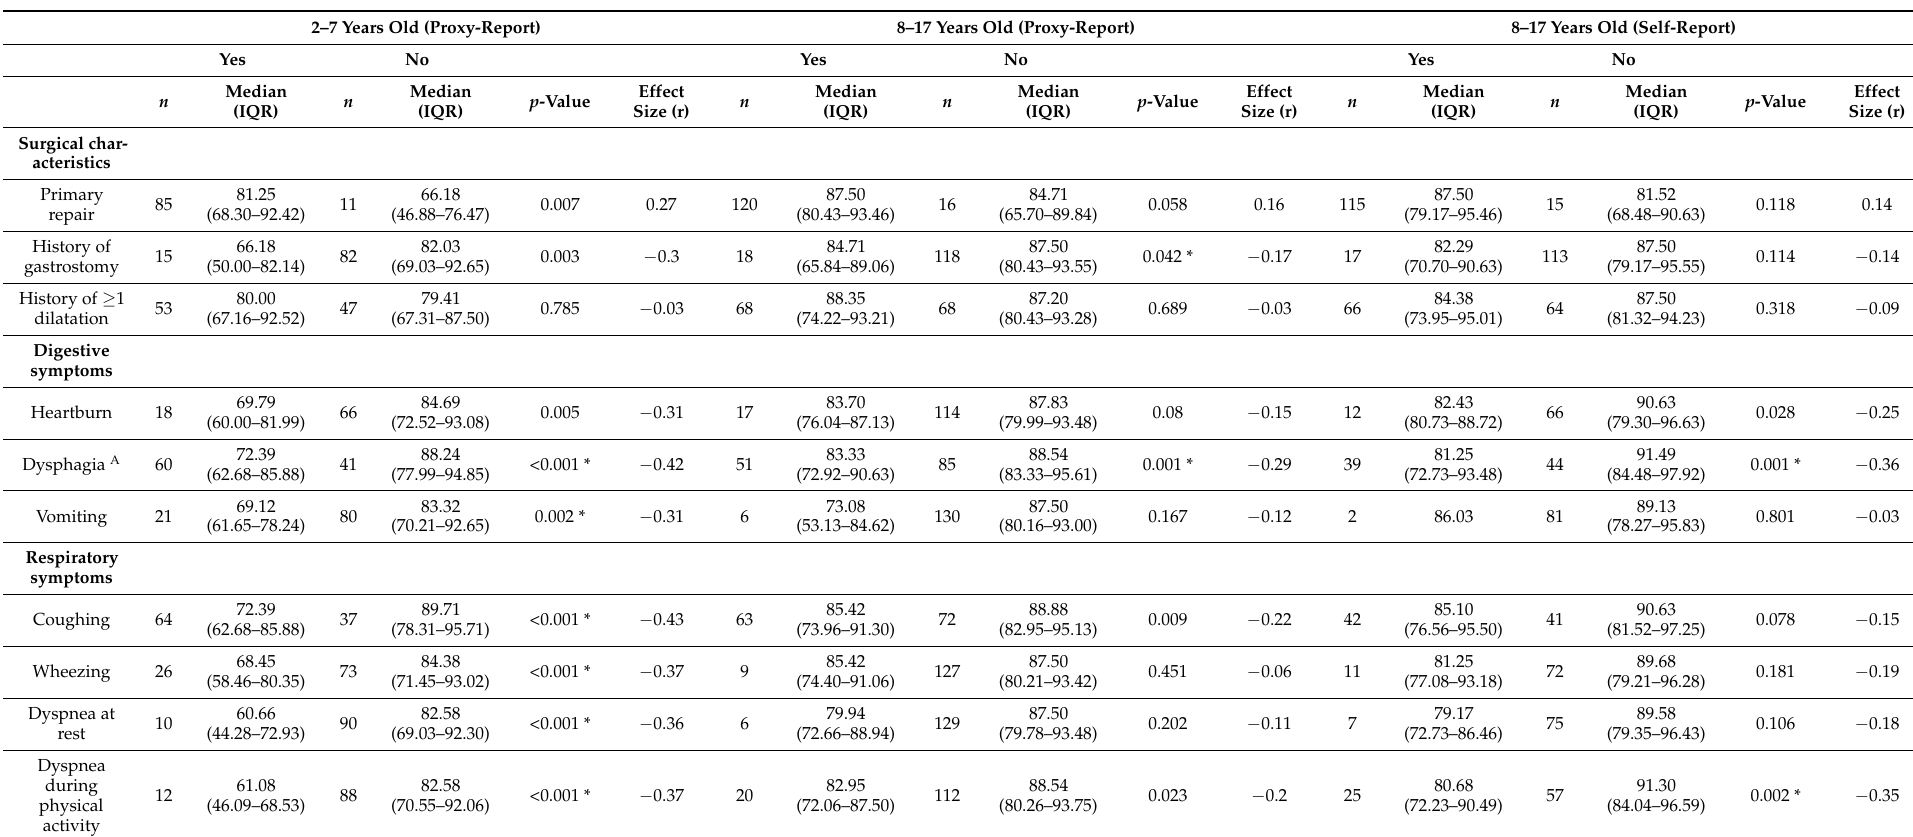
Table 4. ( a ) Comparison between clinical subgroups of total scores of the EA-QOL© questionnaire for children aged 2–7 years old (proxy-reports). Only patients for whom both clinical data and total scores EA-QOL© were available were included in the analyses. Asterisks indicate Bonferroni-adjusted significance p < 0.0025. ( b ) Comparison between clinical subgroups of total scores of the EA-QOL© questionnaire for children aged 8–17 years old, proxy-reports (left) and self-reports (right) between clinical subgroups. Only patients for whom both clinical data and total scores EA-QOL© were available were included in the analyses. A Only children ≥ 12 years old reported these items. Asterisks (*) indicate Bonferroni-adjusted significance p <